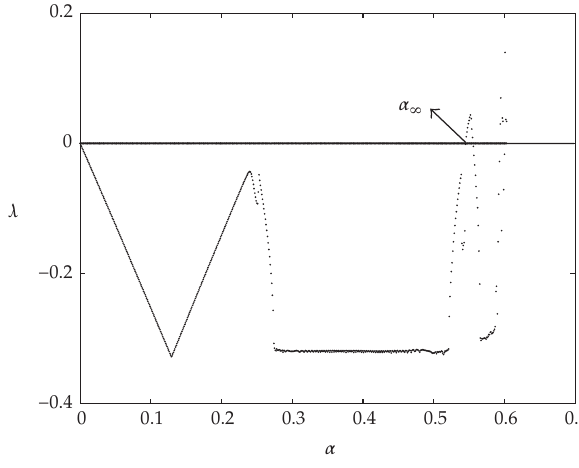
Figure 3: The largest Lyapunov exponent of the system with r (cid:7) 0 . 4 , α (cid:7) (cid:3) 0 , 0 . 63 (cid:4)